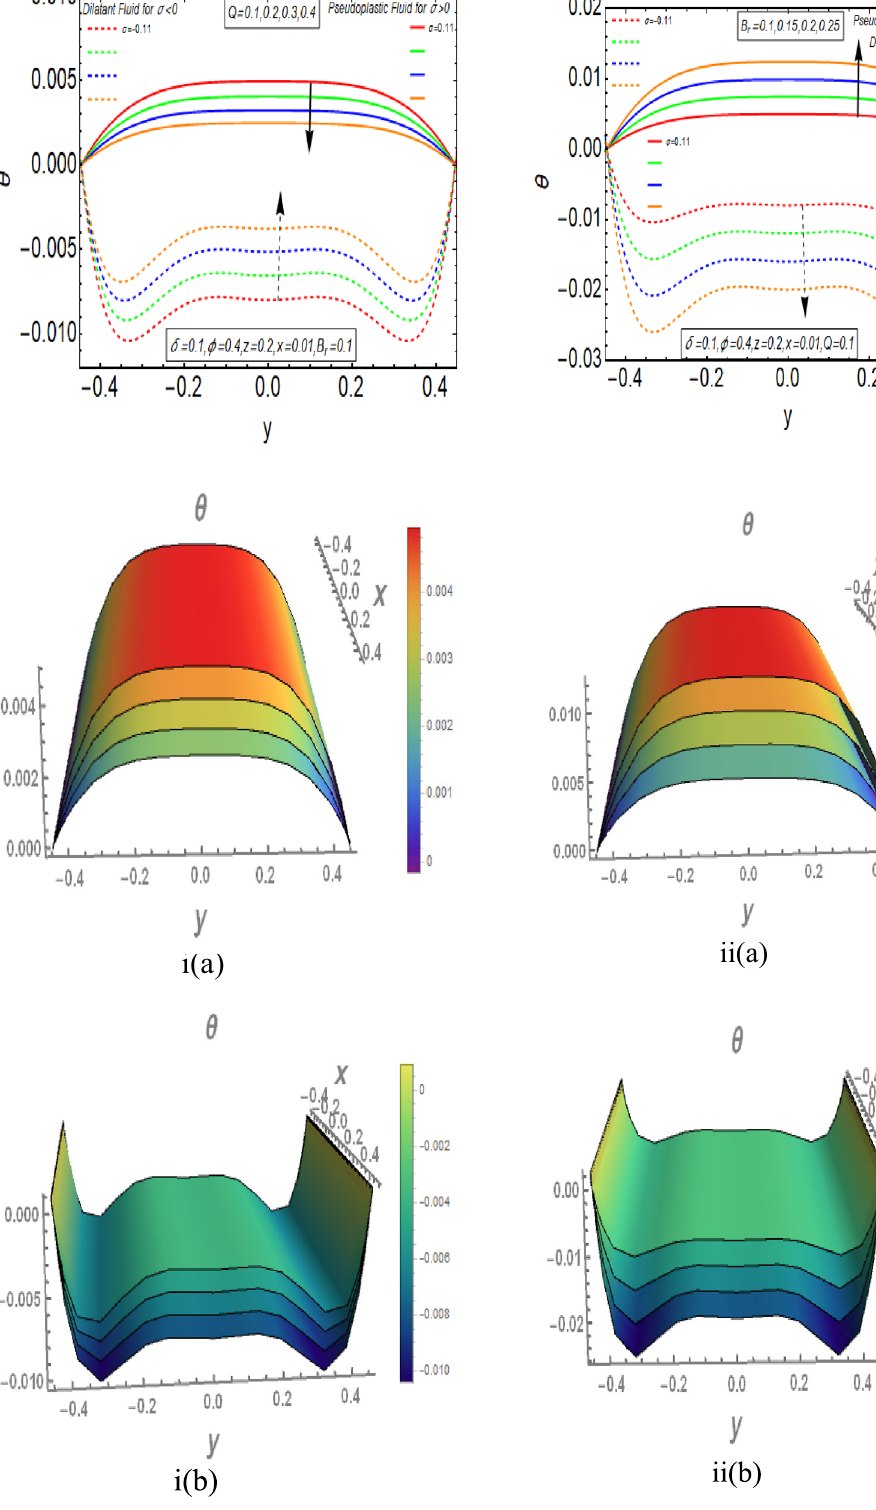
Figure 3. ( i ) Temperature graph for Q with σ > 0 and σ < 0 , i( a ) σ > 0, i( b ) σ < 0. ( ii )Temperature graph for Br with σ > 0 and σ < 0, ii( a ) σ > 0, ii( b ) σ <